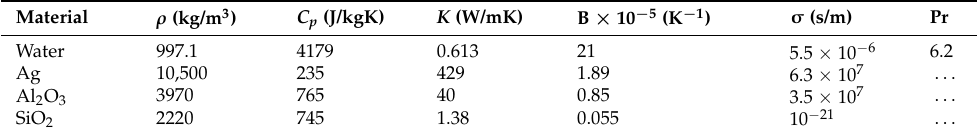
Table 2. Thermo-physical characteristics of base fluids and nanoparticles [23,57,58].